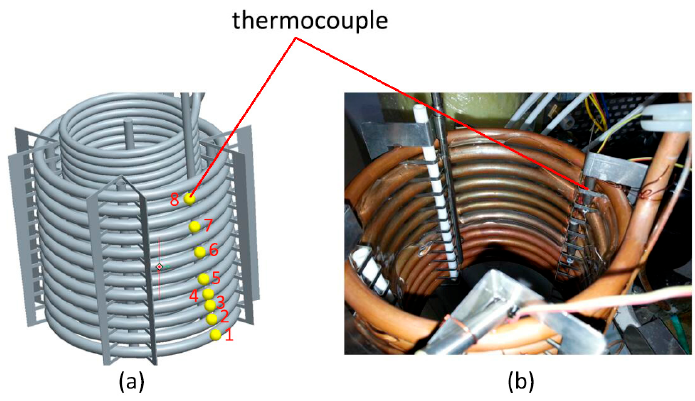
Figure 7. Arrangement of thermocouple: ( a ) physical model; and ( b ) experiment.